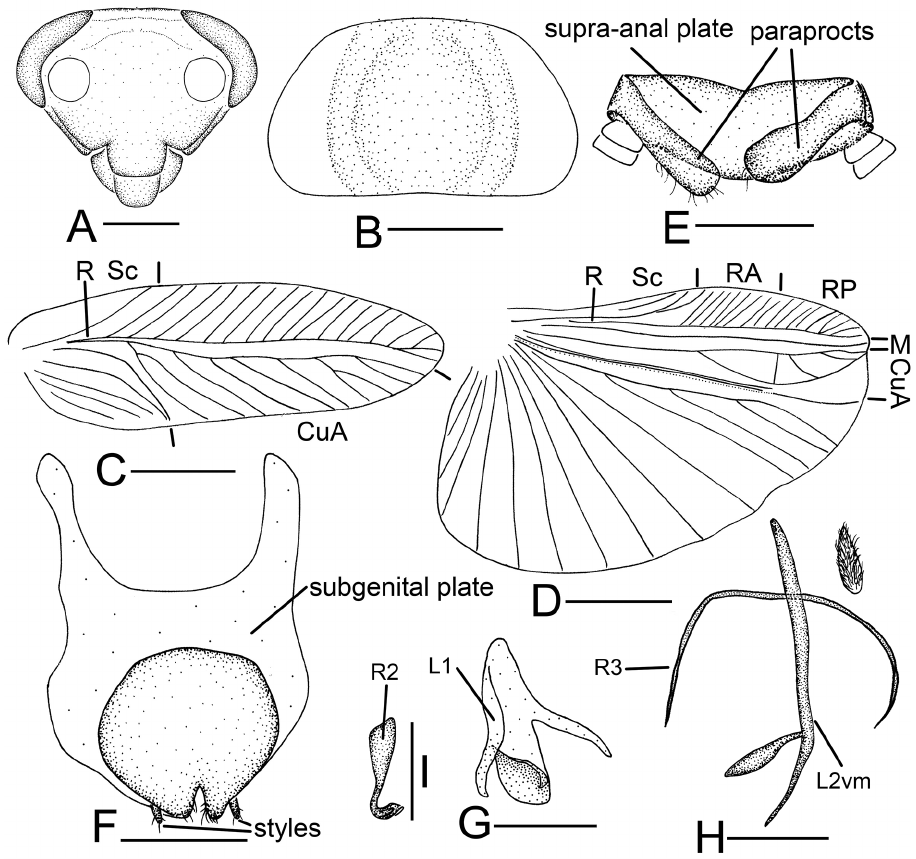
Figure 2. Sorineuchora formosana (Matsumura, 1913) male from China, Yunnan, Xishuangbanna, Mengla. A head, frontal view B pronotum C tegmen D hind wing (the dotted line indicates wing fold) E supra-anal plate, ventral view F subgenital plate, dorsal view G phallomere L1 H phallomere L2vm and R3 I phallomere R2. Scale bars: 0.5 mm ( A, E–I ), 1.0 mm ( B ), 2.0 mm ( C, D ).